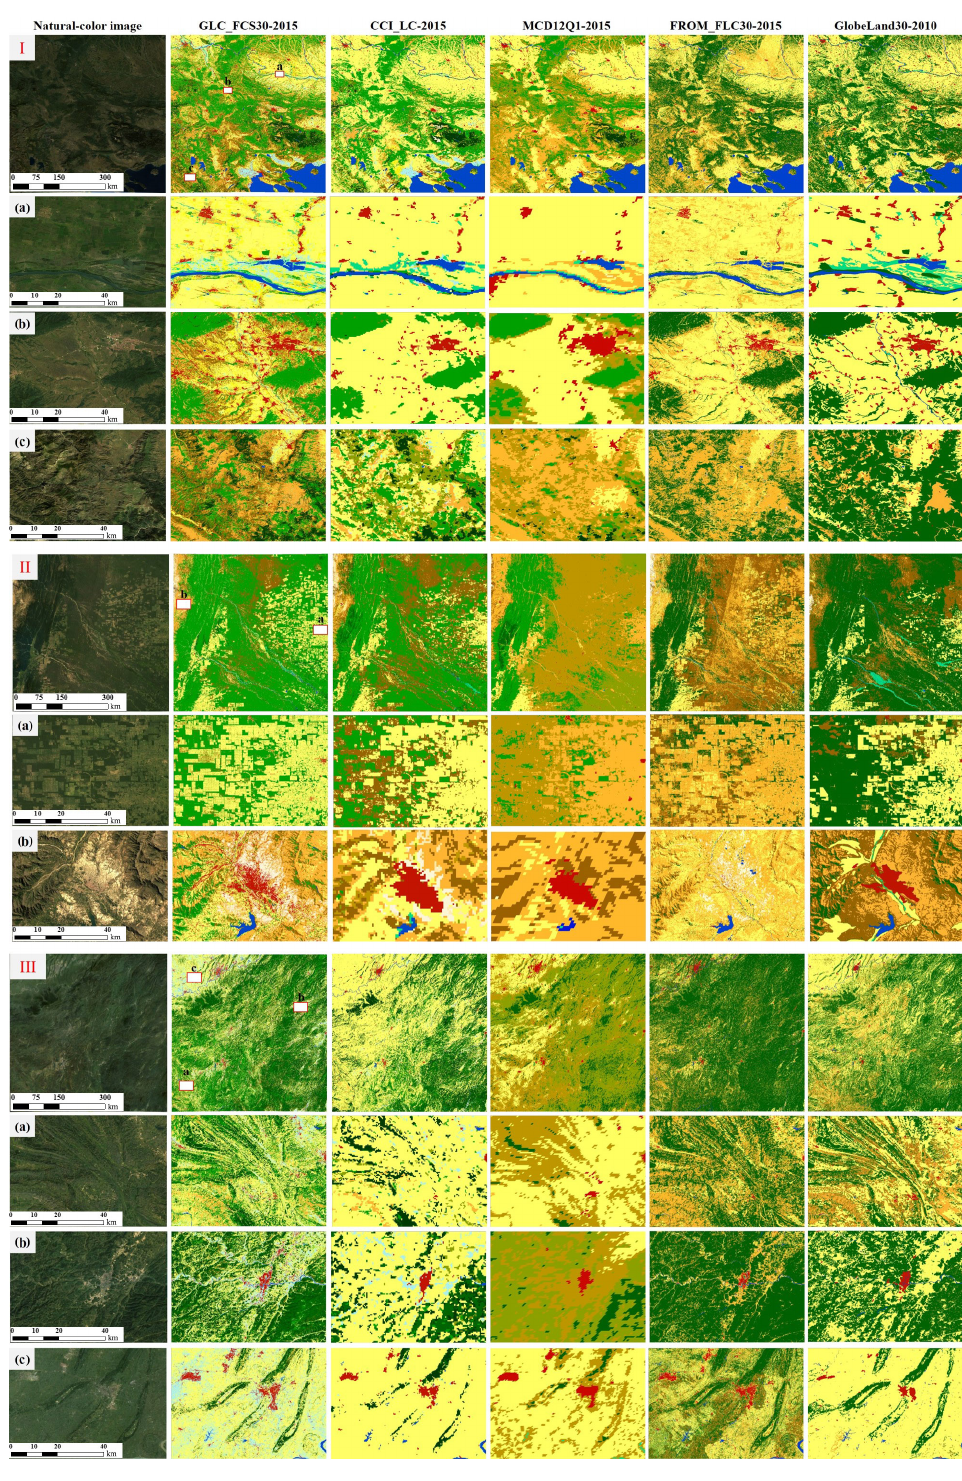
Figure 8. Comparison between GLC_FCS30-2015 and other land-cover products (CCI_LC-2015 products developed by Defourny et al., 2018; the MCD12Q1-2015 developed by Friedl et al., 2010; the FROM_GLC-2015 developed by Gong et al., 2013; and the GlobeLand30 developed by Chen et al., 2015) in three 5 ◦ × 5 ◦ regions. In each case, two to three local enlargements (a–c) with the size of 40km × 60km were used to reveal further details of each land-cover